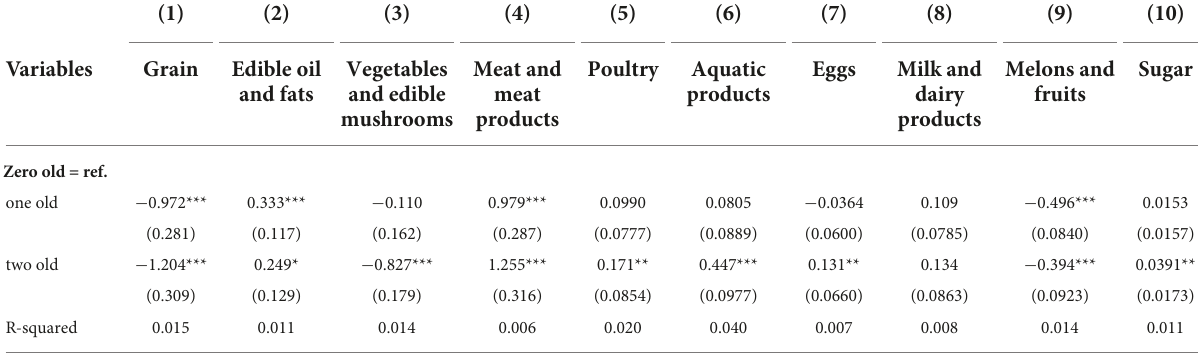
TABLE 5 Regression of the proportion of food consumption (%) on the household composition.